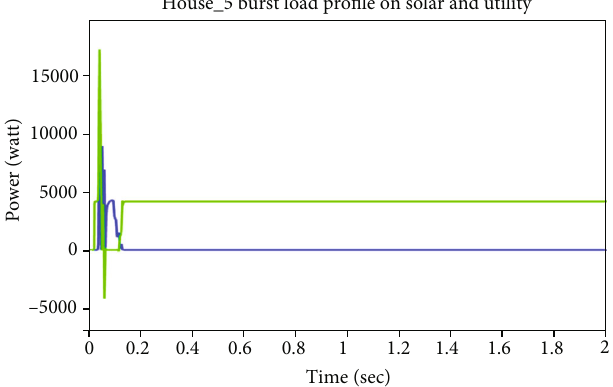
Figure 40: Burst load pro fi le of house